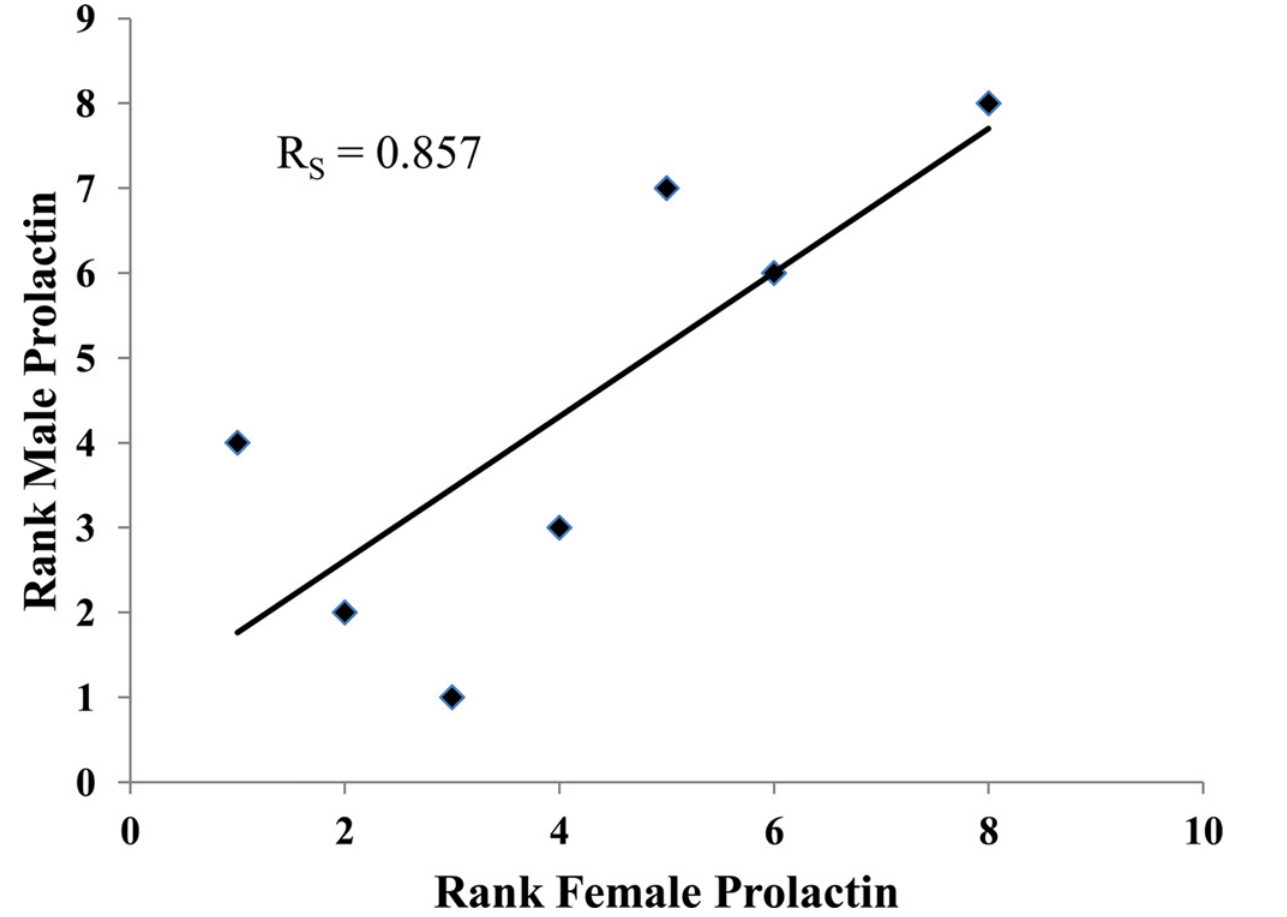
Fig 1. Male-Female Correlation. The correlation between rank prolactin levels in male and female pair-bonded tamarins in Study